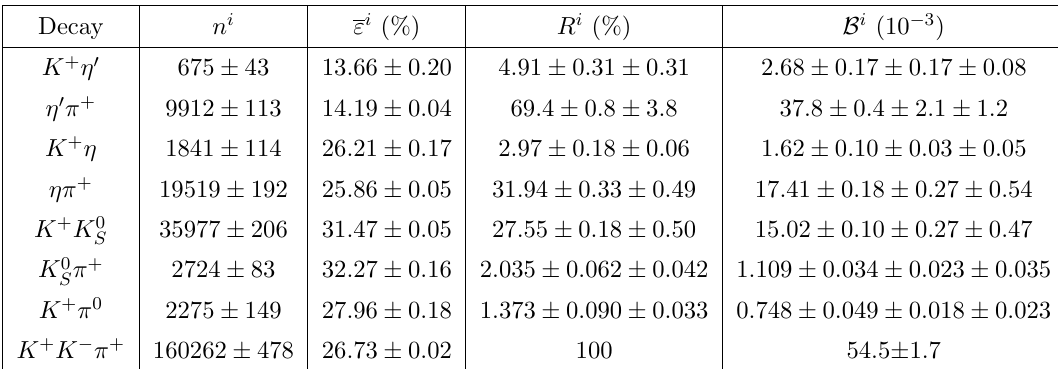
Table 3 . Summary of the signal yields, average detection e(cid:14)ciencies, relative BFs and absolute BFs of individual signal decay modes. The (cid:12)rst uncertainty is statistical, the second is systematic, and the third is external, from the BF of the normalization mode D + uncertainties on e(cid:14)ciencies are due to the limited MC event statistics.